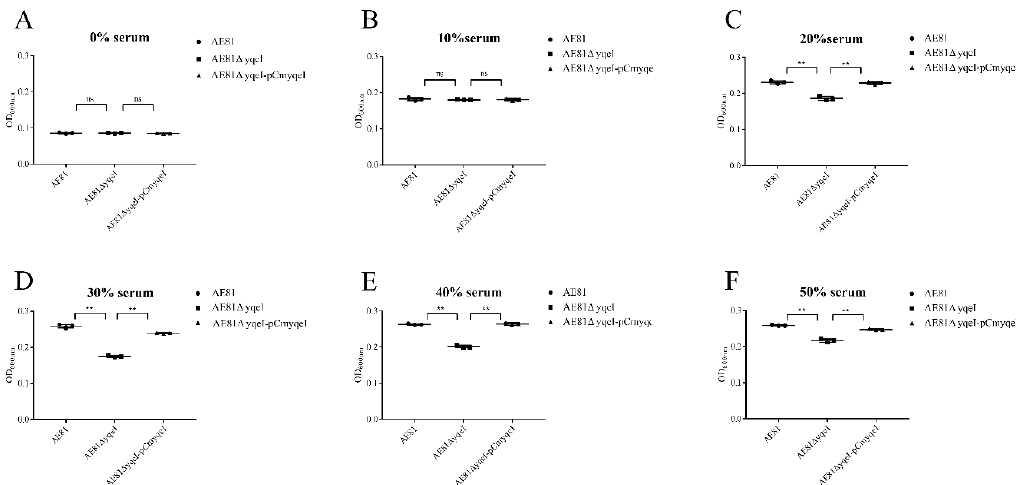
Figure 4. Bacterial resistance to chicken serum. Growth was determined at OD 600nm . ( A ) SPF chicken serum was added at concentrations of 0%; ( B ) SPF chicken serum was added at concentrations of 10%; ( C ) SPF chicken serum was added at concentrations of 20%; ( D ) SPF chicken serum was added at concentrations of 30%; ( E ) SPF chicken serum was added at concentrations of 40%; ( F ) SPF chicken serum was added at concentrations of 50%.